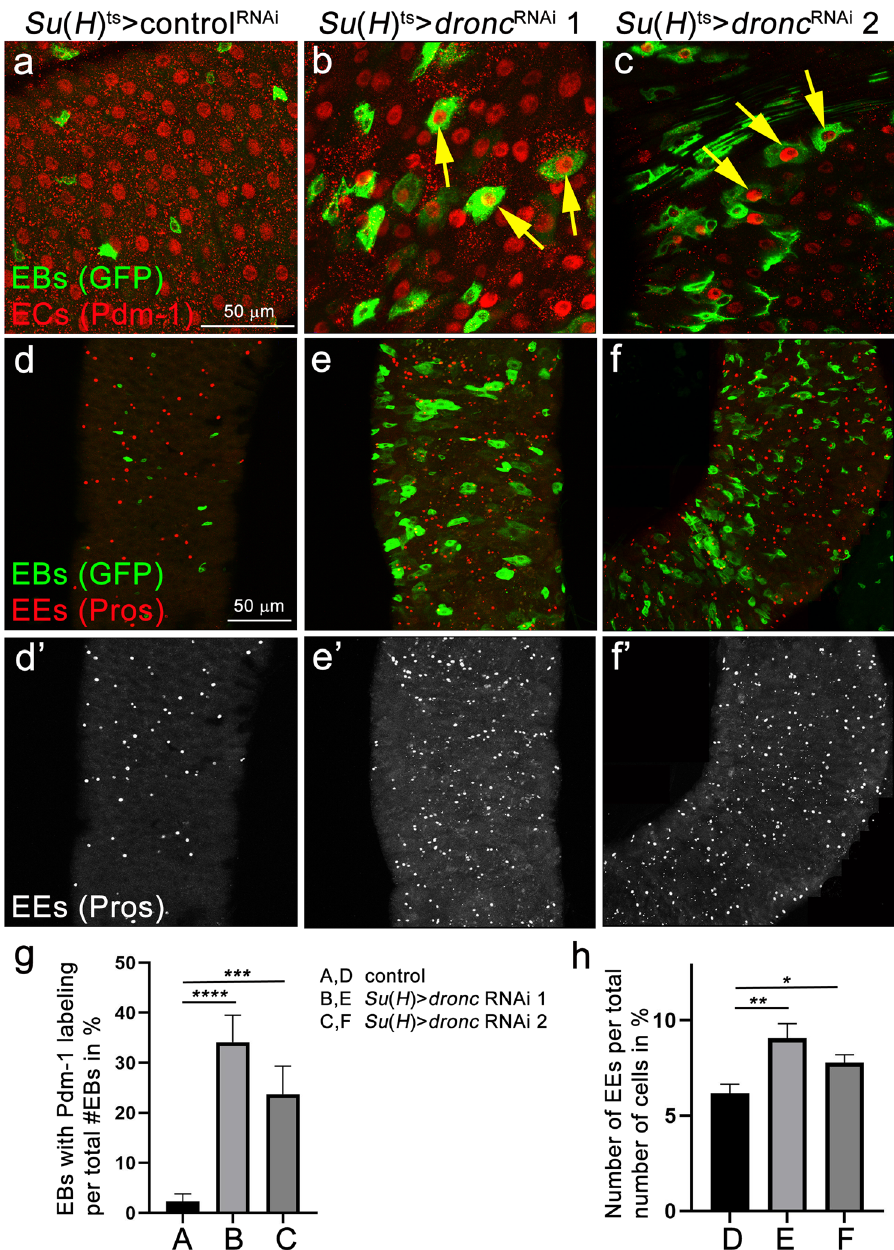
Figure 4. Down-regulation of dronc in EBs causes differentiation defects. (a-c) Shown are regions R4ab of control midguts ( a ) and of midguts in which dronc was down-regulated in EB cells using Su(H) - Gal4 ts ( b , c ). These midguts were labelled with GFP (to visualize EBs) and Pdm-1 antibodies which labels nuclei of ECs. Yellow arrows in ( b , c ) point to GFP/Pdm-1 double positive cells. Two different dronc RNAi transgenes were used: line 1 = P{GD12376}v23033; line 2 = P{KK104278}v100424. Luciferase RNAi was used as a control in ( a ). Complete genotypes: ( a ) Su(H)-Gal4 UAS-GFP tub-Gal80 ts ; UAS - luciferase RNAi; ( b , c ) Su(H)-Gal4 UAS-GFP tub-Gal80 ts / UAS-dronc RNAi line 1 ( b )/line 2 ( c ). Scale bar: 50 µm. ( d – f ) Prospero (Pros) antibody (red in d – f ; grey in d’ – f’ ) was used to label enteroendocrine cells (EE) in regions R4ab of control midguts ( d ) and midguts in which dronc was down-regulated in EBs using Su(H) - Gal4 ts ( e , f ). EBs are labelled by GFP (green in d – f ) due to Su(H ) > GFP expression. Genotypes as in ( a – c ). Scale bar: 50 µm. ( g ) Quantification of the data in ( a – c ). GFP/ Pdm-1 double positive cells were normalized to the total number of GFP-positive cells and illustrated in %. GFP/Pdm-1 double positive and GFP-positive cells were manually counted and analysed by one-way ANOVA with Holm-Sidak test for multiple comparisons. Error bars are SEM. ****p < 0.0001; ***p < 0.001. Number of midguts analysed: n = 7 (control), 4 ( dronc RNAi 1), 4 ( dronc RNAi 2). ( h ) Quantification of the Pros labelings in ( d’ – f’ ). All Pros-positive cells (corresponding to EEs) were counted in region R4ab and normalized to the total number of cells. Data were analyzed by one-way ANOVA with Holm-Sidak test for multiple comparisons. Error bars are SEM. **p < 0.01; *p < 0.05. Number of midguts analysed: n = 12 (control), 7 ( dronc RNAi 1), 6 ( dronc RNAi